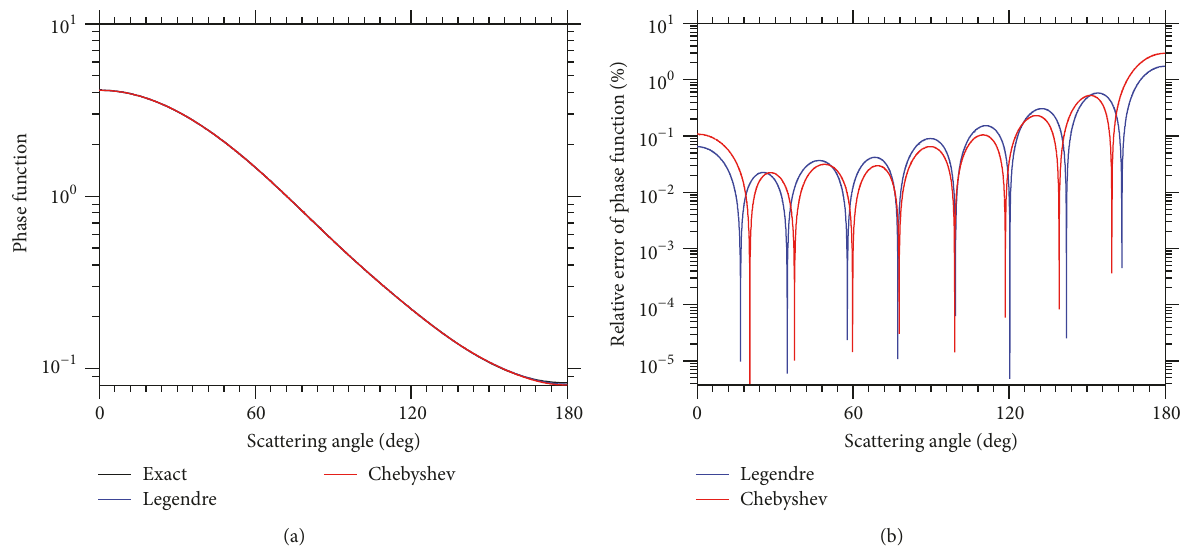
Figure 2: Phase function of soot (a) and relative error of phase function (b) in 8